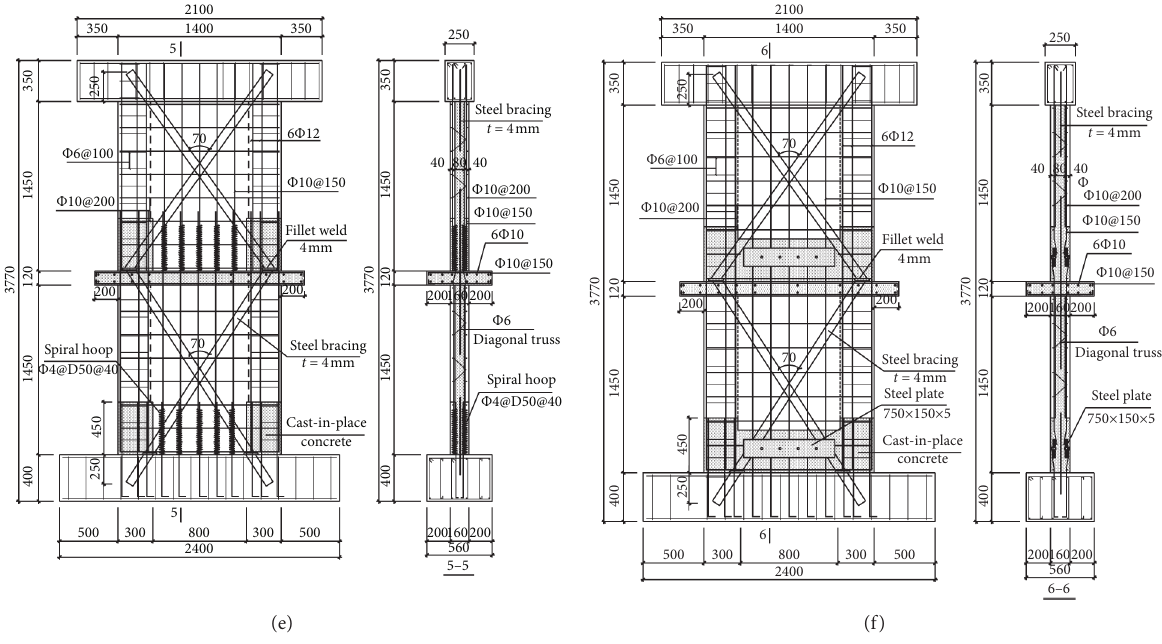
Figure 2: Geometry and reinforcement details of specimens (unit of mm). (a) SW1. (b) SRCSW1-1. (c) SRCSW1-2. (d) SW2. (e) SRCSW2-1. (f)